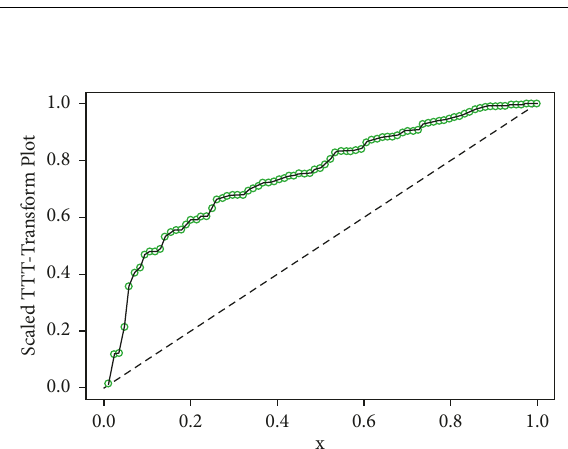
Figure 11: The TTT Plot of the airplane windshield data.